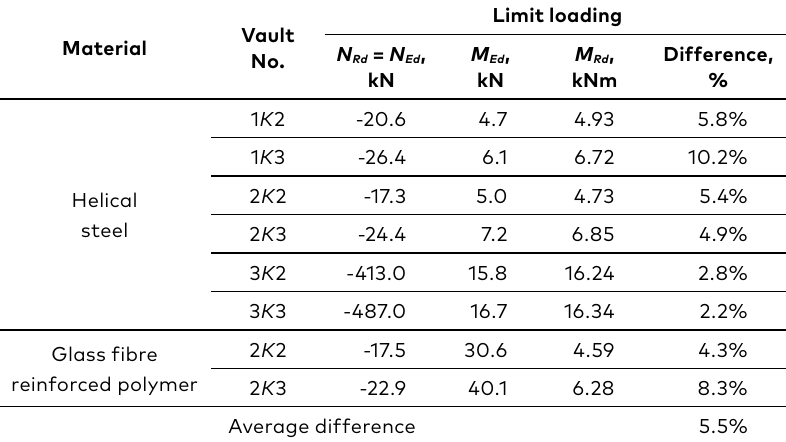
Table 2. Comparison of the designed algorithm to experiments – achieved calculation values for helical and glass fibre reinforced polymer reinforcement